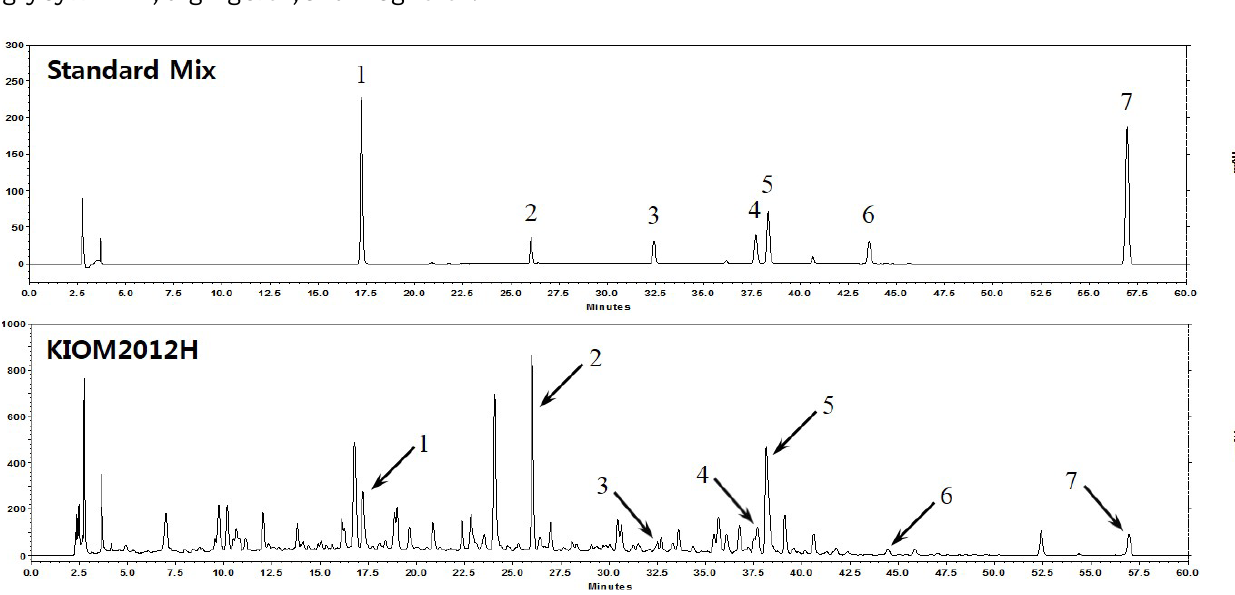
Figure 1. HPLC chromatogram of standard markers and KIOM2012H. Standard markers of liquiritin (1), arctiin (2), matairesinol (3), arctigenin (4), glycyrrhinzin (5), 6-gingerol (6), and magnolol (7) are shown in the above. HPLC chromatogram of KIOM2012H is shown in the bottom with arrows corresponding each standard